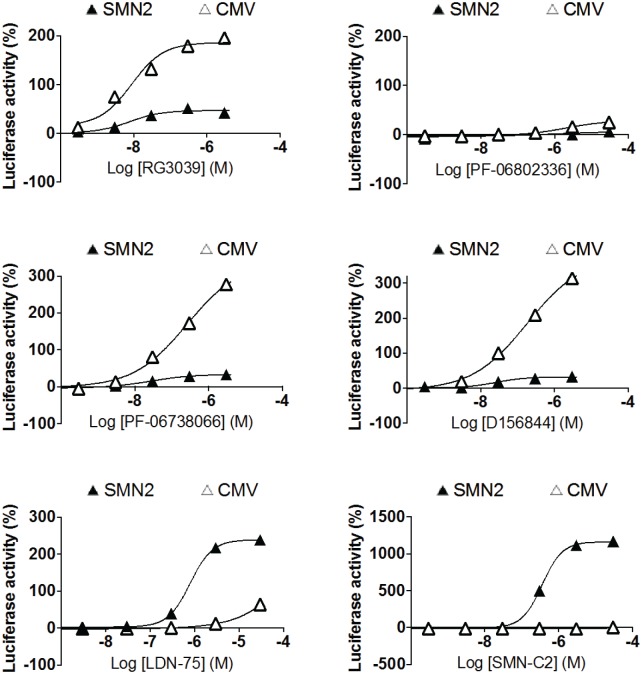
Effect of DAQ-DcpSi on luciferase activity driven by either the SMN2 promoter and SMN splicing cassette (filled triangles) or CMV promoter (open triangles).All data shown as mean ± range of duplicate determinations for a representative experiment of two performed which gave very similar results. Where not shown, error bars are within the size of the symbols.